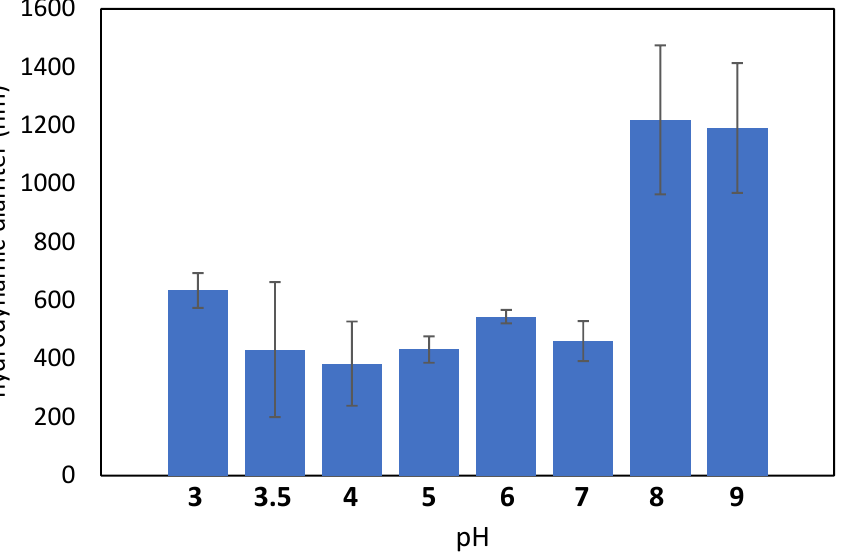
Figure 6. The hydrodynamic diameter of nisin, measured by DLS analysis, in aqueous suspension as a function of pH.